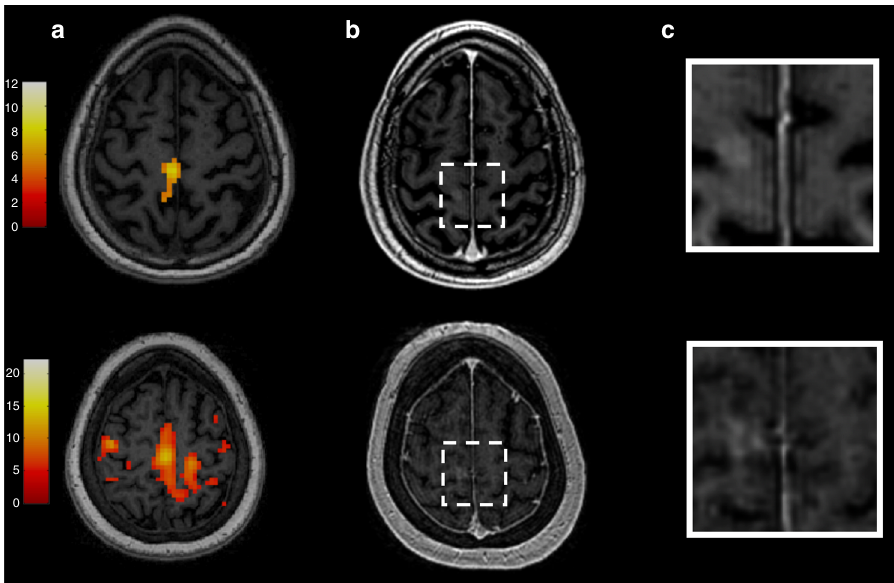
Fig. 3 Feasibility of blood – brain barrier opening using MRgFUS in the leg control region of the right primary motor cortex. a Leg control region mapping using motor-task functional MRI (fMRI). b , c show con fi rmation of successful blood – brain barrier permeabilization in the sonicated primary motor cortex area as demonstrated by new gadolinium enhancement in T1-weighted imaging. Subject one is represented in the top row and subject four in the bottom